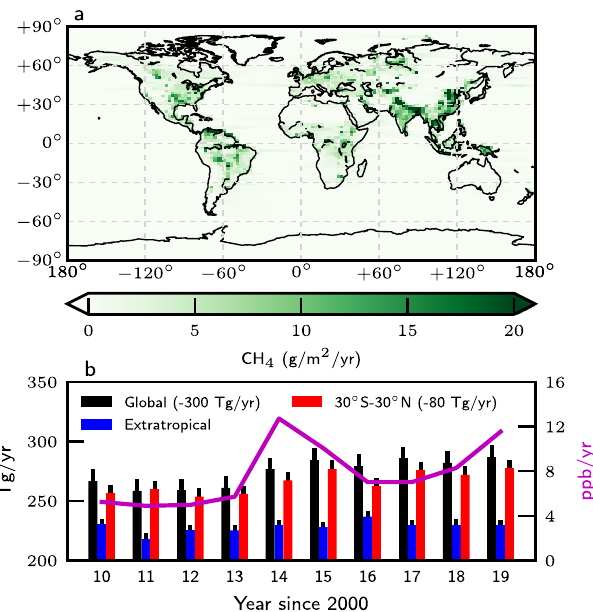
Fig. 1 Distribution and year-to-year variations of CH 4 emissions. a Mean annual a posteriori CH 4 emissions (Tg/year) 2010 – 2019, inclusively, and b the corresponding annual mean emissions for the globe (minus 300 Tg) further separated into the tropics (minus 80 Tg) and the extratropics. The thinner vertical lines in b denote the 1 − σ values about the annual mean values. The purple line denotes the atmospheric growth rate (ppb/year) from the NOAA ground-based network (https://www.esrl.noaa.gov/gmd/ ccgg/trends_ch4/).